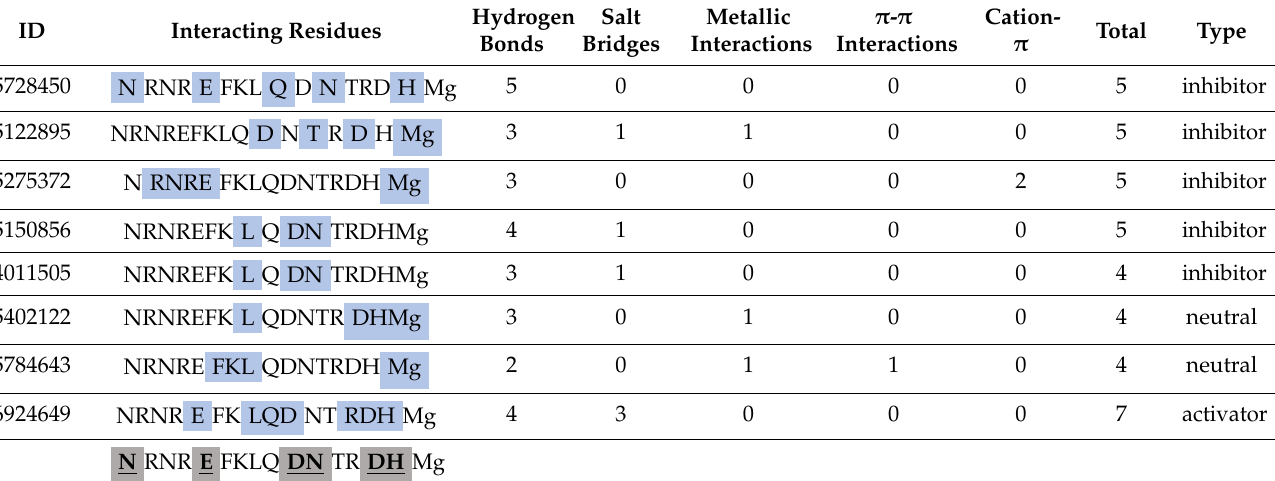
Table 4. Overview and comparison of contacts made between small compounds and nSMase2. Indicated are compounds’ IDs. The residues in nSMase2 that are involved in interaction with the compounds are shown as shaded amino acid abbreviations. Further, the number of observed hydro- gen bonds, salt bridges, metallic interactions, pi-pi interactions, or cation-pi interactions between compounds and nSMase2 are shown, as well as the total number of interactions per compound. For comparison in the bottom line, the residues Asn130, Glu364, Asp510, Asn512, Asp638 and His639 representing conserved active site residues contacting the SM substrate [26] are